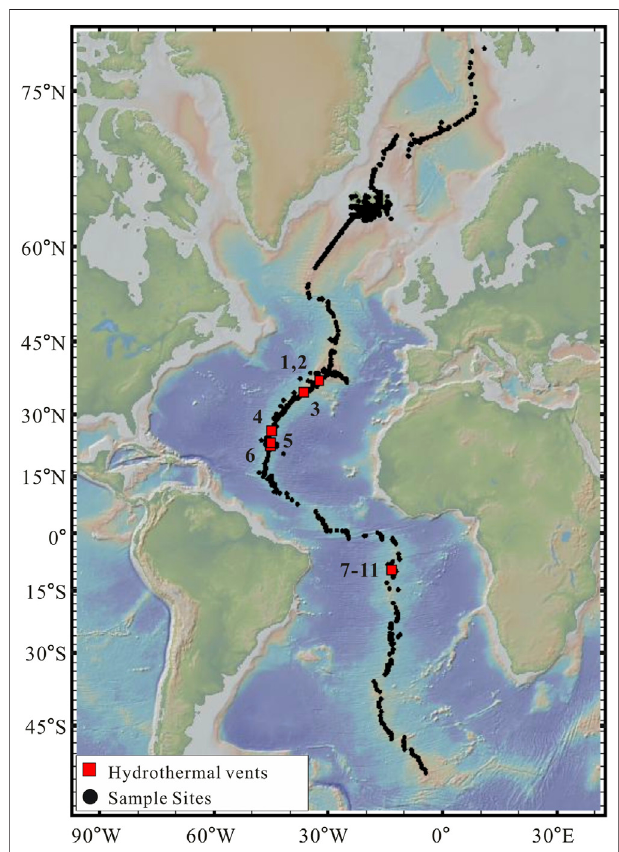
FIGURE1| Basalt samplingsites and locationsofthe11knownseabed hydrothermal vents (for information, see Table 1 ). Shaded relief bathymetric map from GeoMapApp, 2021.